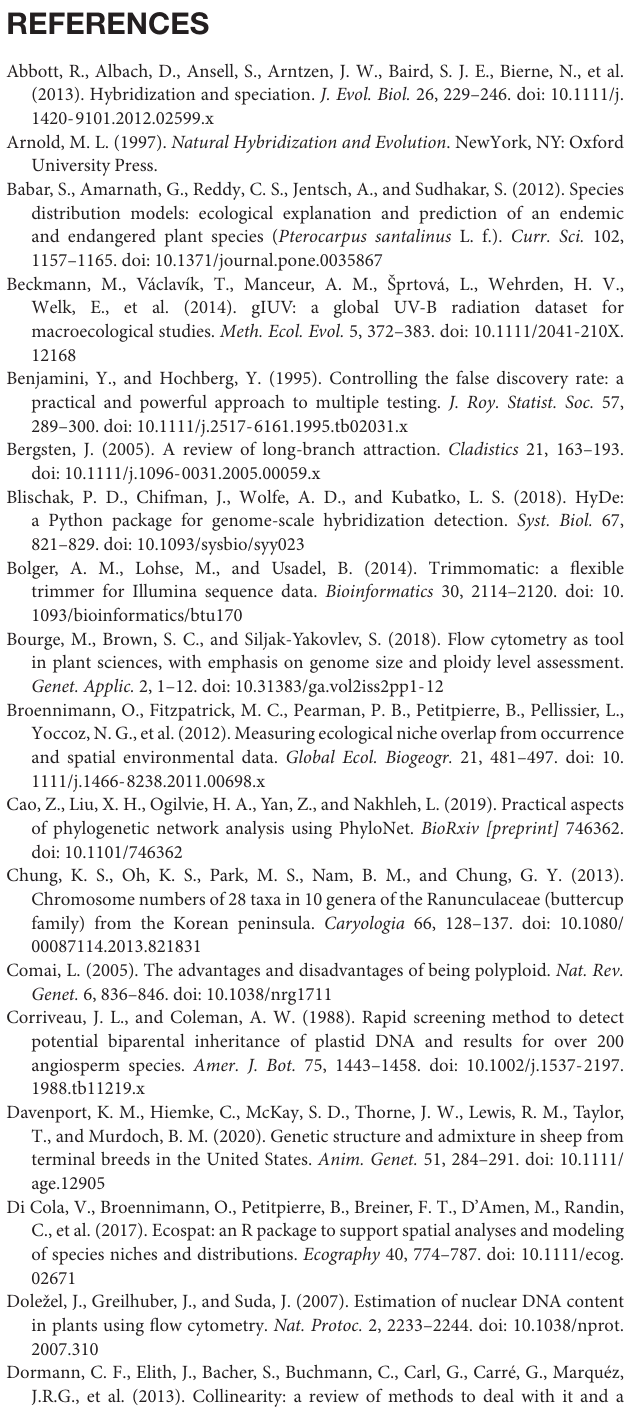
Supplementary Table S9 | HyDe analysis of Clematis pinnata and its putative parents in each population using the complete SNP data. Sample size of C. pinnata : eight populations, 28 individuals. Supplementary Table S10 | Percentage contributions and permutation importance of environmental variables included in MaxEnt modeling for Clematis pinnata and its putative